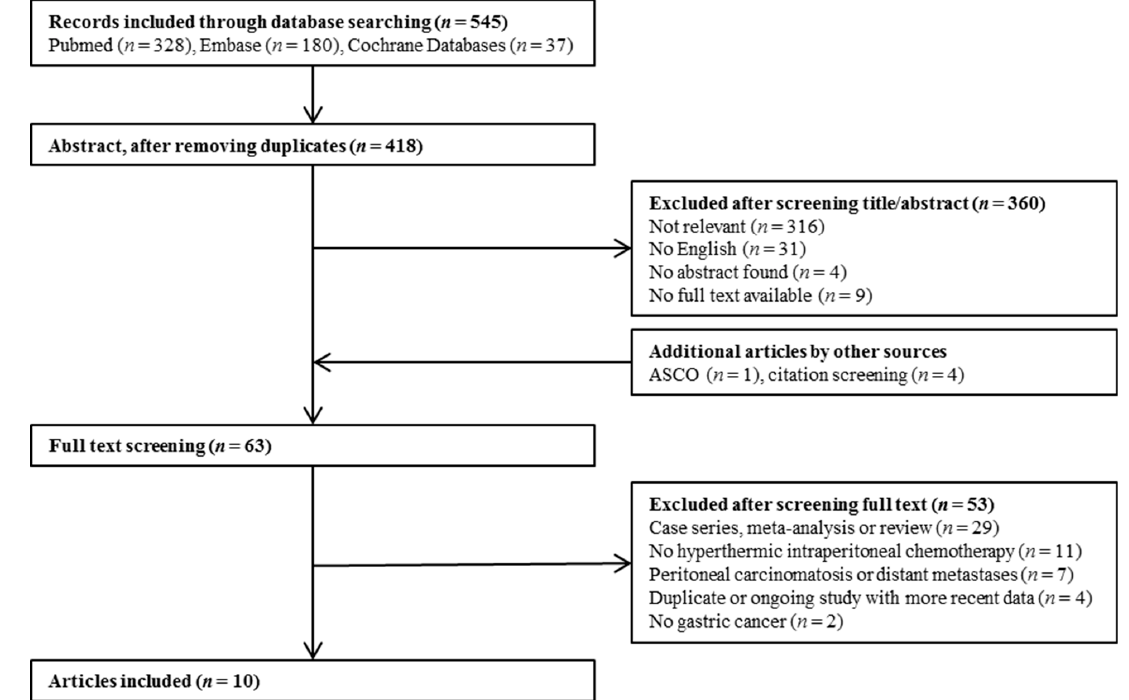
Figure 1. Article selection flowchart .